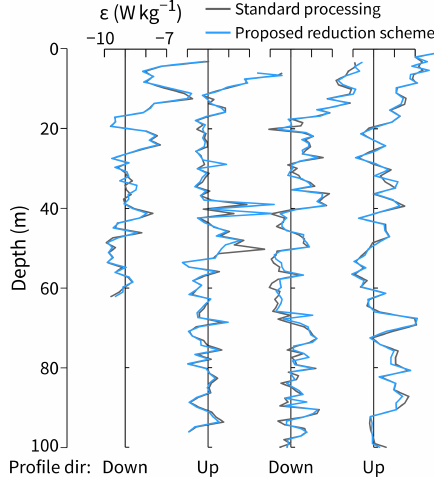
Figure 5. Testing the proposed data reduction scheme for shear measurements against the standard processing approach. One up- ward and one downward profile from each of the two FCS units were arbitrarily chosen for this comparison.